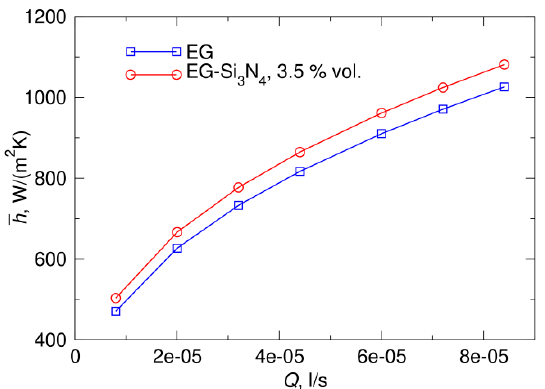
Figure 9. Computational results for the enhancement of the heat transfer coefficient for the EG-Si 3 N 4 nanofluid at the nanoparticle volume fraction of 3.5% over a range of nanofluid volume flow rates corresponding to Re between 200 and 2100 for pure EG.